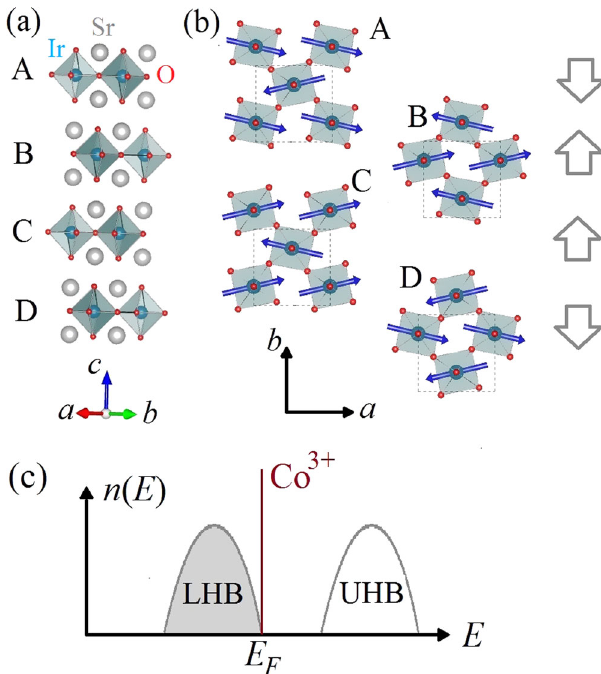
Fig. 1 Crystal, magnetic and electronic structures. a Crystal structure of Sr 2 IrO 4 (SIO) 13, 14 (A – D layers are identi fi ed). b Detailed view of each layer projected into the ab plane, showing the rotation pattern of the IrO 6 octahedra and the orientation of the Ir magnetic moments 16, 18, 19 . The net moment of each layer is indicated in the right, leading to the ↓↑↑↓ stacking pattern at zero magnetic fi eld. c Schematic density of states n ( E ) of Sr 2 Ir 0.95 Co 0.05 O 4 (SICO) near the Fermi level E F , showing the J eff = 1/2 lower an upper Hubbard bands (LHB and UHB) and a localized Co acceptor level. A metallic or Anderson insulating phase would arise if the energy E E 3 + F (corresponding to a Co Co 3 þ of the acceptor level was located below doping), whereas a gapped insulator would occur if instead this level was above E F (corresponding to a Co 4 + isoelectronic substitution). The (cid:2) E quantum phase transition occurs where E , and the corresponding F Co 3 þ quantum critical fl uctuations are electronic excitations from the lower Hubbard band to the acceptor